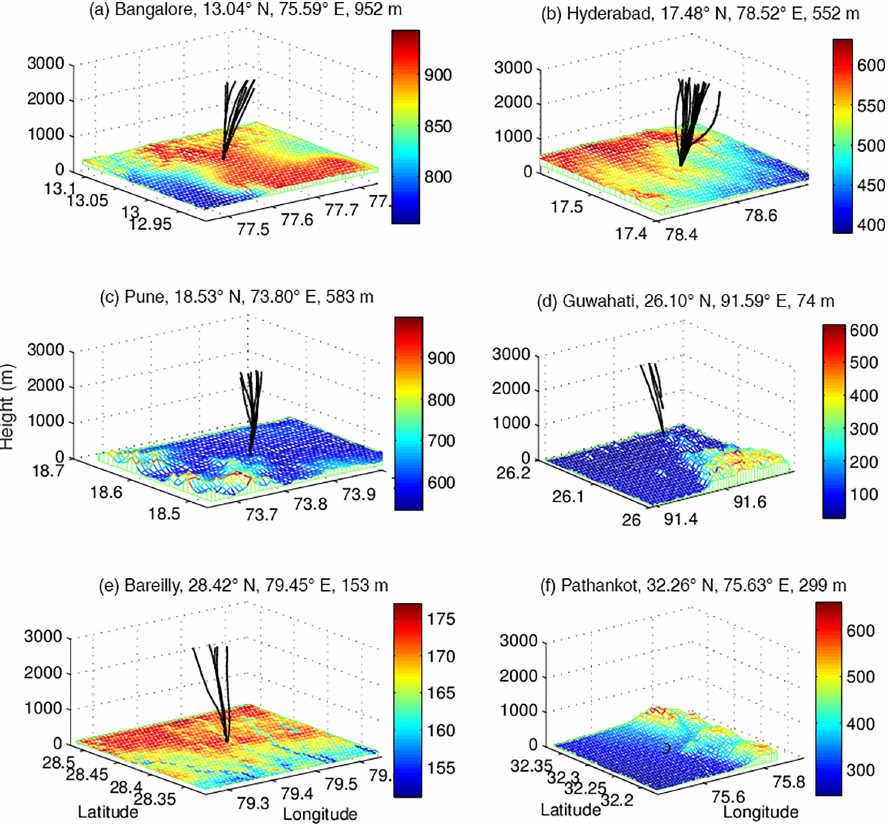
Figure 2. Topographical features surrounding the locations of radiosonde launch over the six sites: (a) Bangalore, (b) Hyderabad, (c) Pune, (d) Guwahati, (d) Bareilly, and (e) Pathankot in the Indian monsoon region, along with profiles of balloon trajectories from the surface up to